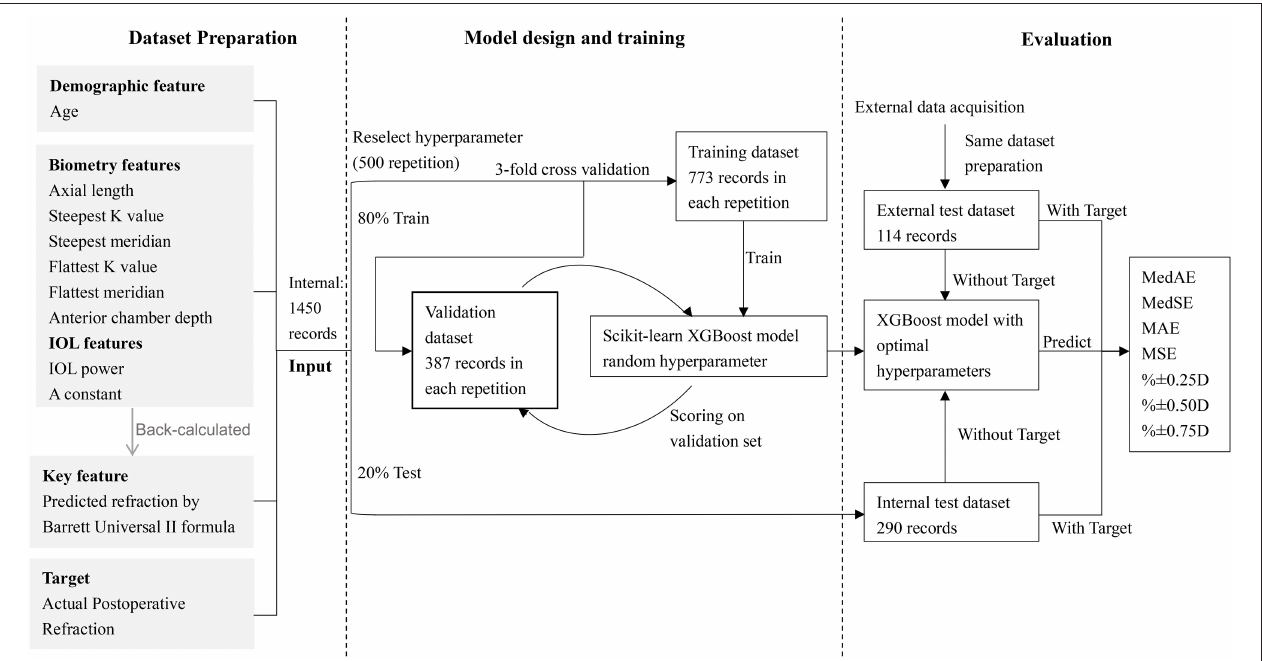
FIGURE 1 | The flow diagram of the XGBoost